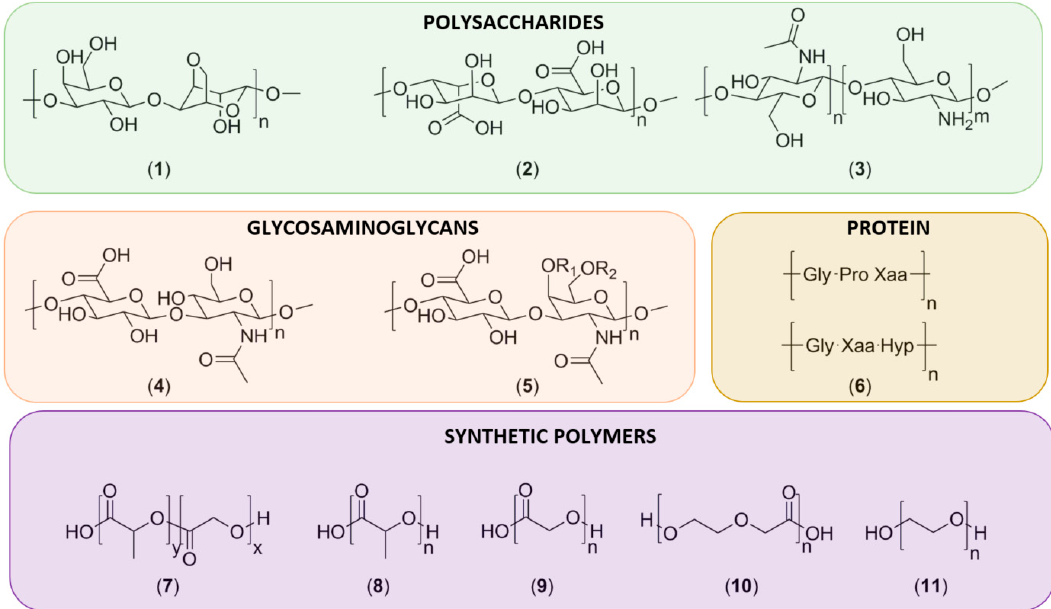
Figure 3. Structures of commonly used (bio)polymers in cartilage repair. Displayed are the natural polymers ( 1 ) agarose, ( 2 ) alginate, ( 3 ) chitosan with partial deacetylation, ( 4 ) hyaluronic acid, ( 5 ) chondroitin-4-sulfate, where R1 = SO 3 H; R2 = H or chondroitin-6-sulfate, where R1 = H; R2 = SO 3 H, ( 6 ) collagen, showing two common tripeptide repeats, where Hyp represents L-4-hydroxyproline and X represents any amino acid other than Gly, Pro or Hyp, and is often a basic or acidic amino acid. Synthetic polymers ( 7 ) poly(lactic- co -glycolic acid), ( 8 ) poly(lactic acid), ( 9 ) poly(glycolic acid), ( 10 ) polydioxanone and ( 11 ) poly(ethylene glycol).